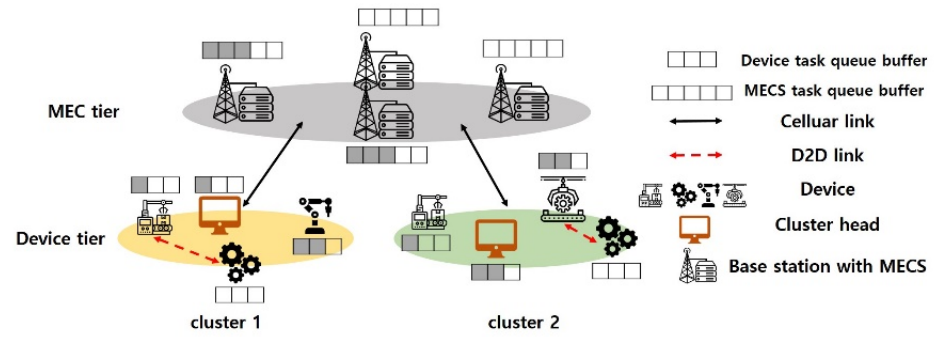
Figure 1. The proposed system architecture of an IIoT environment.